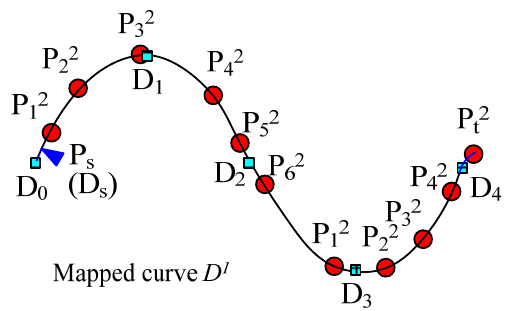
Figure 9. The mapping result for the different starting points.